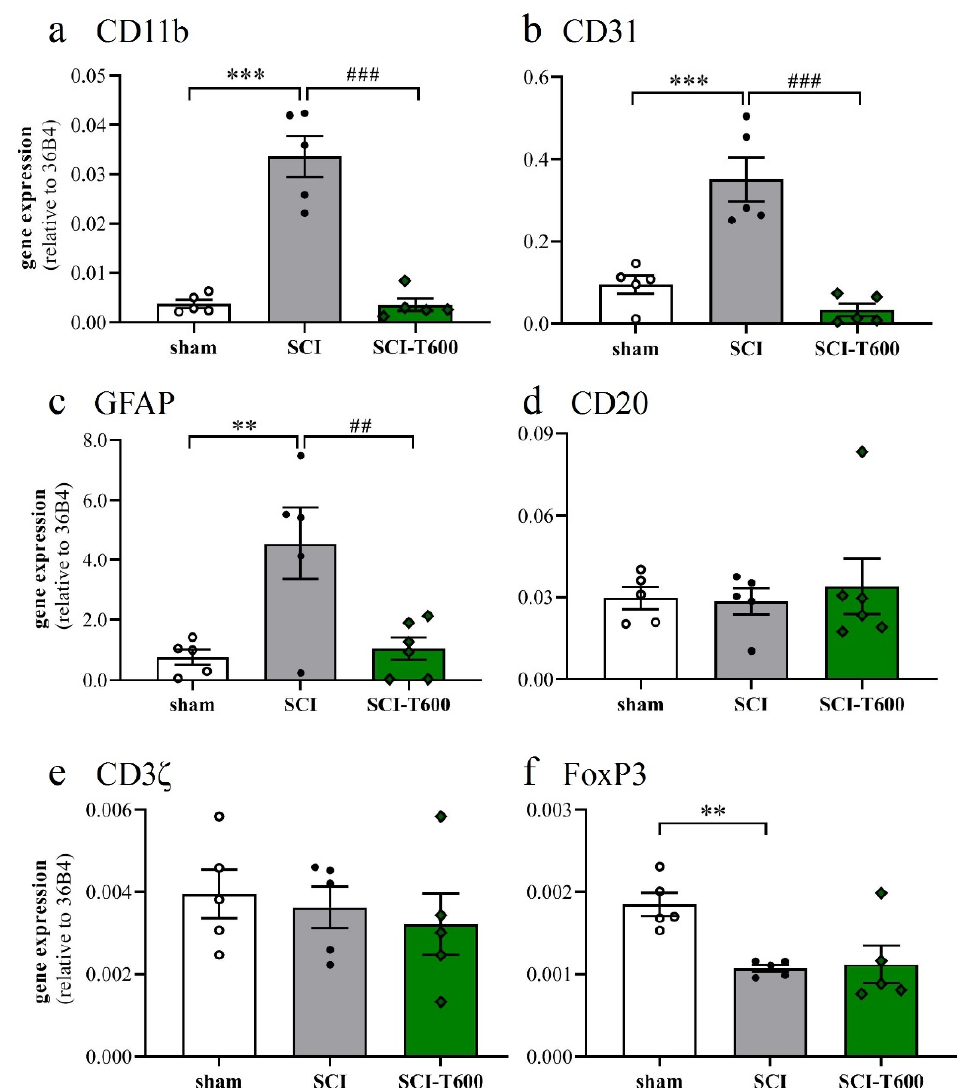
Figure 6. Expression of marker genes of cell type activation. At 4 dpo, RNA extracts from the spinal cord and cerebral cortex were analyzed with quantitative RT-PCR (treatment conditions abbreviated as in Figure 2). ( a ) Gene expression of CD11b, marker of microglia and macrophage [ANOVA, F (2, 12) = 46.3, p < 0.0001]; ( b ) CD31, endothelial cells, macrophages and lymphocytes [ANOVA, F (2, 12) = 23.9, p < 0.0001]; ( c ) GFAP, astrocytes [ANOVA, F (2, 12) = 8.6, p < 0.01]; ( d ) CD20, B-cells [ANOVA, F (2, 12) = 1.6, n.s.]; ( e ) CD3 ζ , T-cells [ANOVA, F (2, 12) = 2.2, n.s.]; ( f ) FoxP3, regulatory T-cells [ANOVA, F (2, 12) = 7.7, p < 0.01]. Significant differences detected with post hoc Dunnett’s tests ( p < 0.05, p < 0.001, p < 0.001) are indicated with **, *** symbols for SCI vs. laminectomy and ##, ### for SCI vs. SCI-T600.